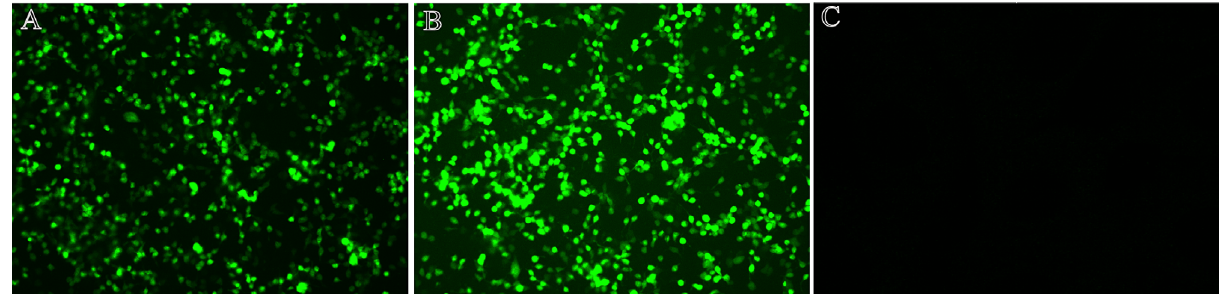
Figure 1. Immuno fl uorescence assay for the recombinant GRA24 and GRA25 protein expressed in 293T cells. 293T cells were transfected with pVAX-GRA24 (A) or pVAX-GRA25 (B) or empty pVAX I